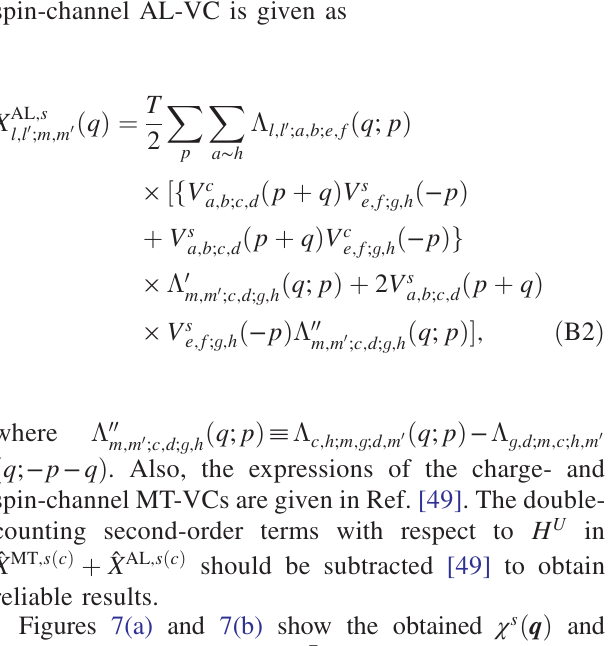
ð q Þ given by the SC-VC theory, x 2 − y 2